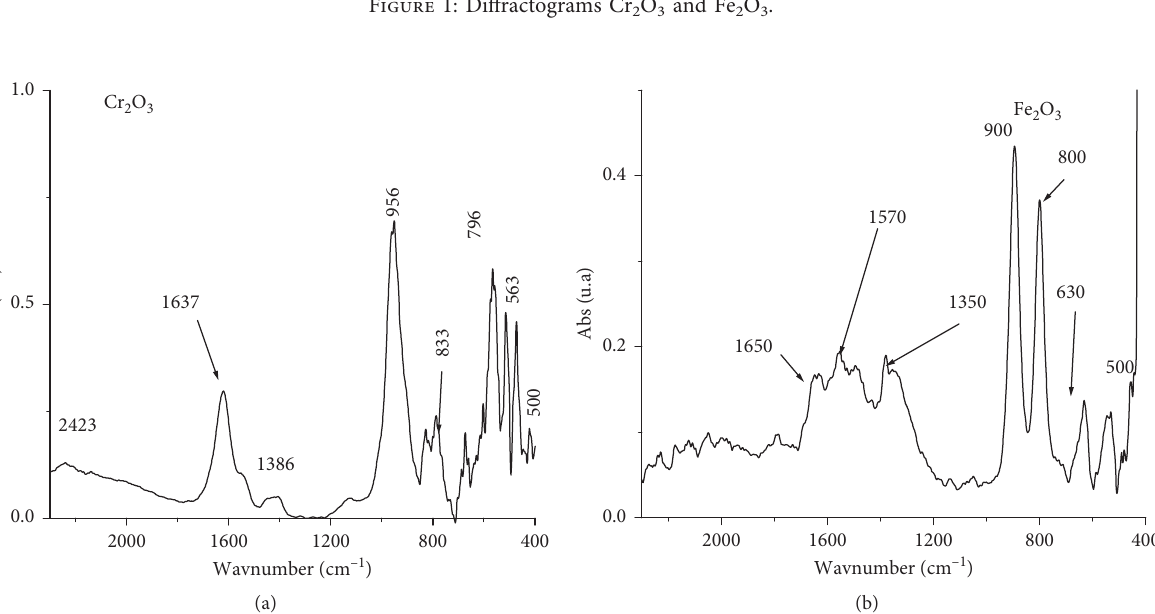
Figure 1: Diffractograms Cr